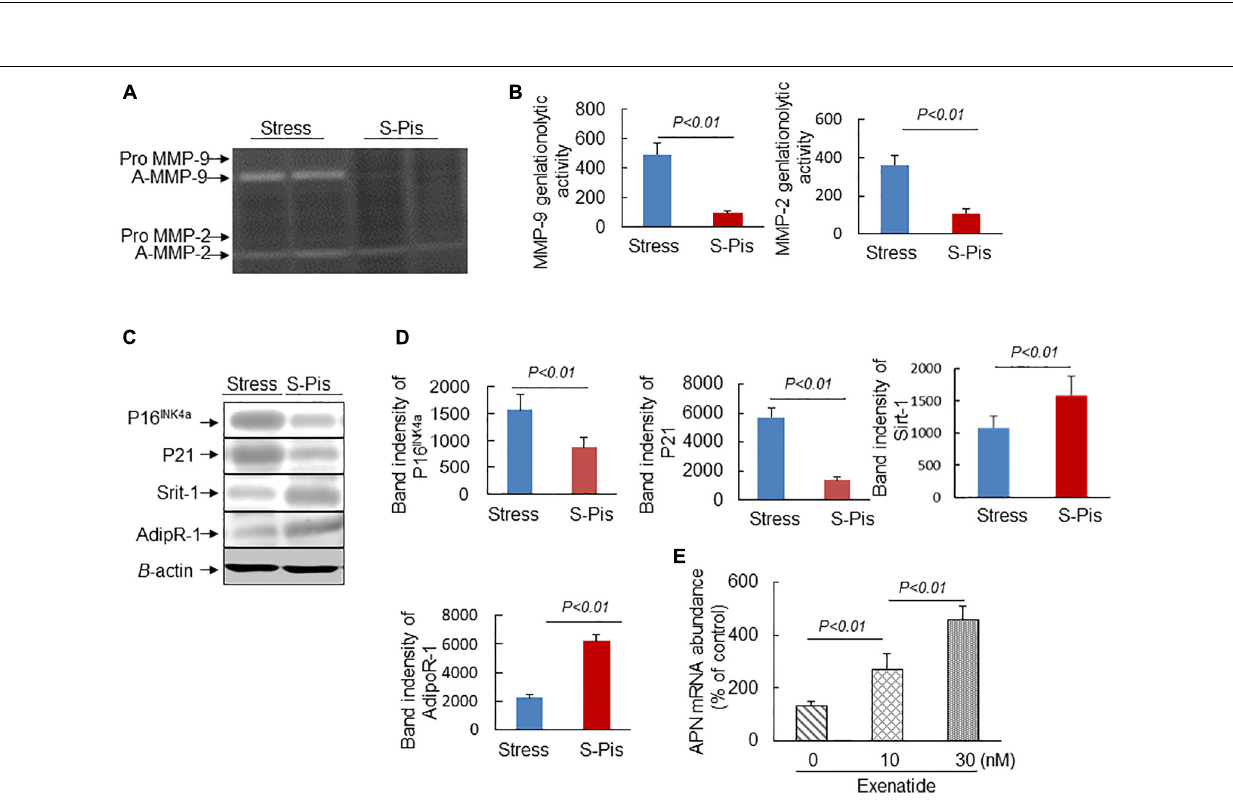
Frontiers in Cell and Developmental Biology |